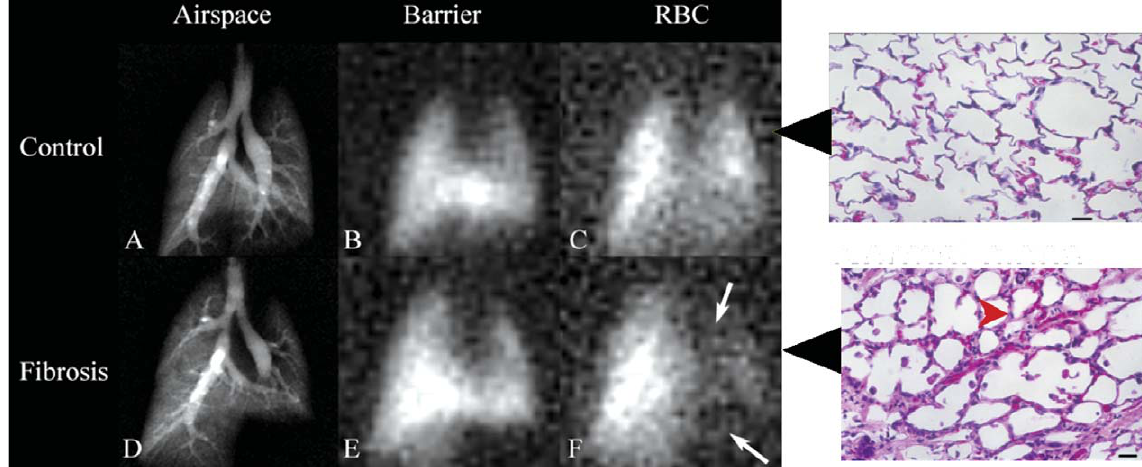
Fig. 19. Gas exchange impairment can be assessed with MR imaging of HP 129 Xe in the three compartments of the lung: airspace (A, D), tissue barrier (B, E), and red blood cells (C, F). Arrows in F indicate diminished 129 Xe uptake in red blood cells (RBC) due to inflammation and fibrosis caused by bleomycin. The thickening of blood gas barrier, confirmed by histology slides, slows down the 129 Xe transfer to gas space. Adapted and reprinted with permission from [23]. Copyright 2006 National Academy of Sciences, USA. (Colours are visible in the online version of